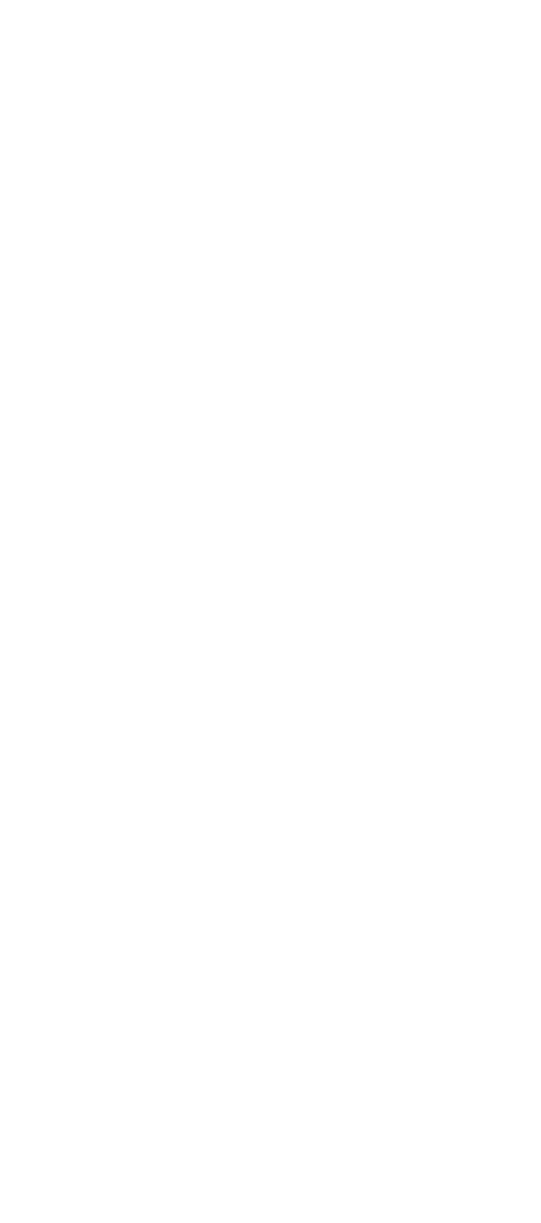
Figure 5. Thermograms showing the point at which the C 12 A 7 in the tested samples melted. Table 3. Free CaO content in selected samples depending on synthesis